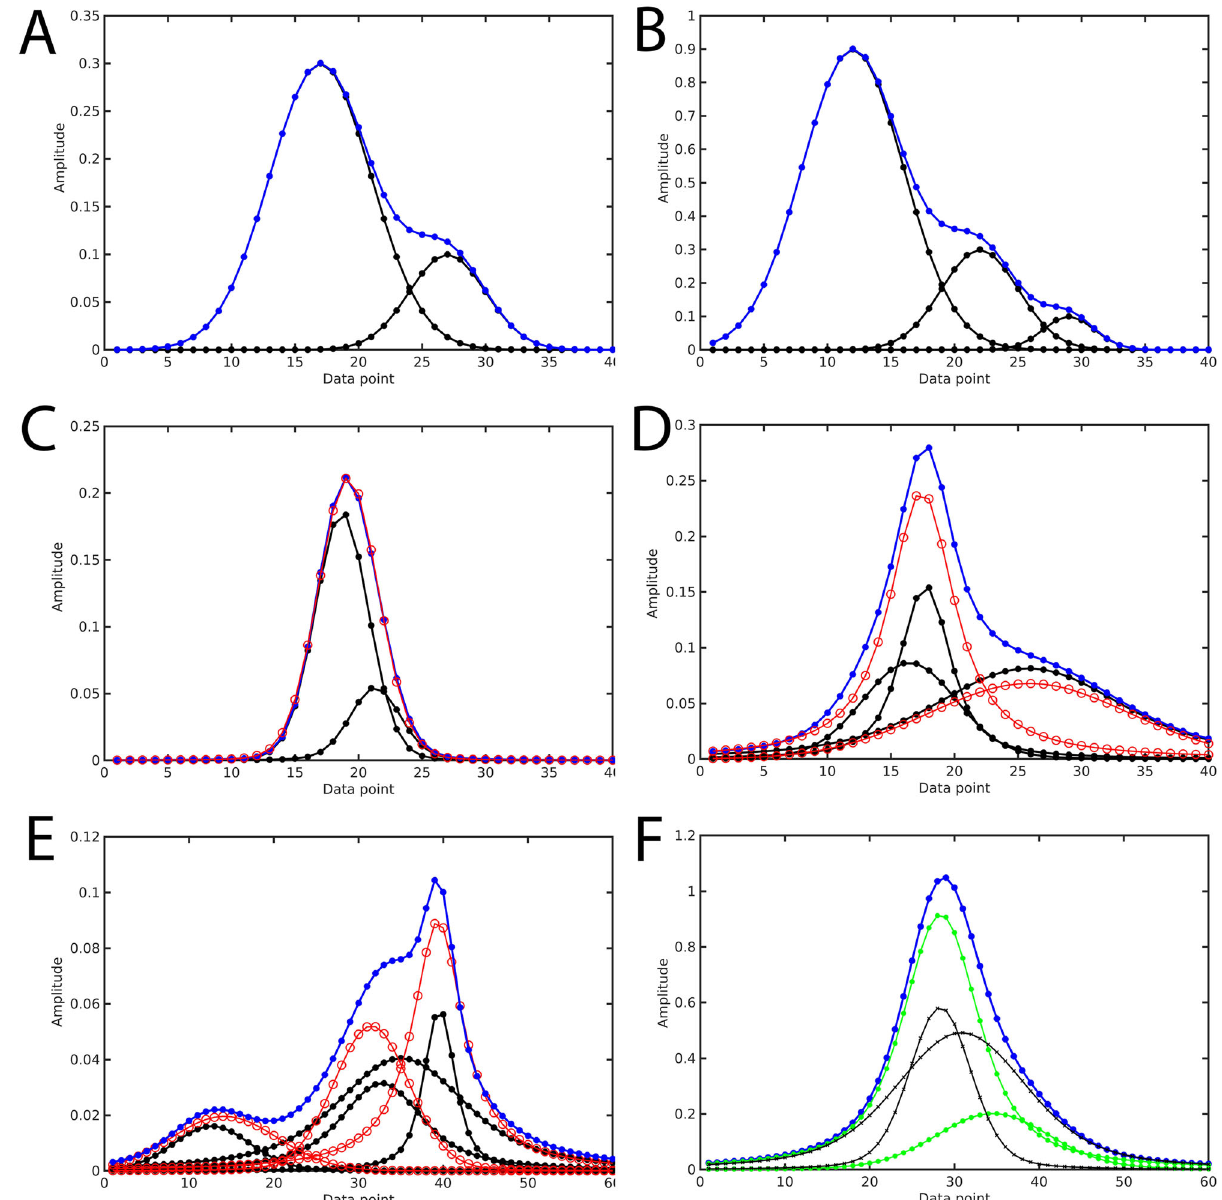
Fig. 1 Examples of 1D NMR training sets of convoluted NMR spectra (blue) and their deconvolutions (black, red). A Sum spectrum (blue) that can be unambiguously deconvoluted into two individual overlapping peaks (black). B Sum spectrum (blue) that can be unambiguously deconvoluted into three individual overlapping peaks (black). C Sum spectrum (blue) of two overlapping peaks (black) can be accurately represented by a single peak (red). D Sum spectrum (blue) generated from three distinct peaks (black), but can also be accurately explained by only two peaks (red). E Sum spectrum (blue) generated from four distinct peaks (black), but can also be accurately explained by only three peaks (red). F Sum spectrum (blue) can be deconvoluted equally well into two distinct peak pairs (one with black crosses and one with green